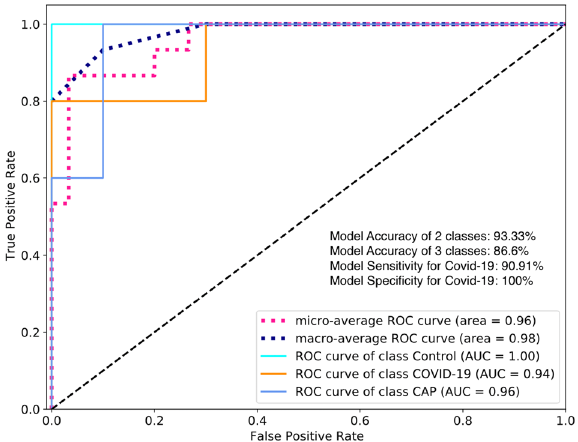
Fig. 4 Performance of CovidCTNet in detecting Control, Covid-19, and CAP. The model ’ s AUC for Covid-19 detection is 0.94 ( n = 15 cases). The accuracy, sensitivity, and speci fi city of the model are shown. The model operation in three classes demonstrates the detection of all three classes including Covid-19 versus CAP and versus Control and in two classes indicates the detection of Covid- 19 as one class versus non-Covid-19 (CAP and Control) as second class.